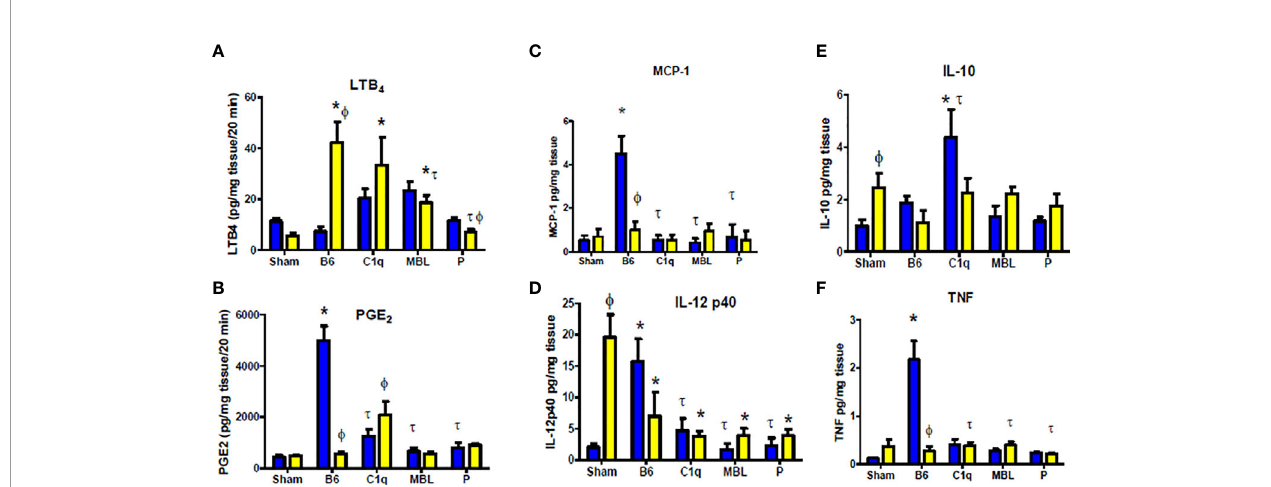
FIGURE 6 | Complement de fi ciency decreases intestinal in fl ammatory secretions in a sex dependent manner. Male (blue) and female (yellow) C57B6L/J WT, C1q -/- , MBL - / - , and P - / - mice were subjected to Sham (pooled from all strains) or IR treatment with 120 min reperfusion. Intestinal sections were analyzed ex vivo for